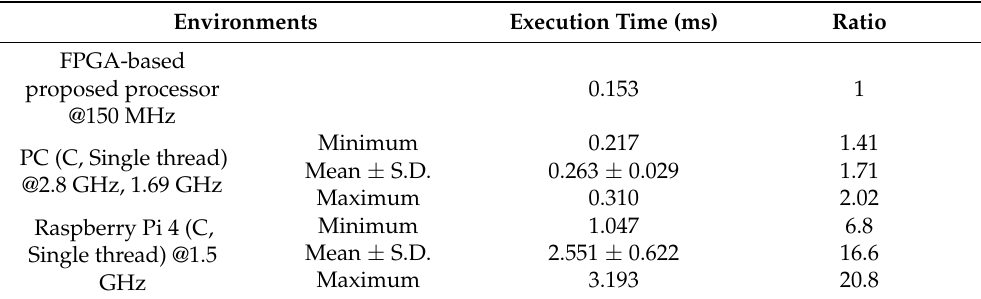
Table 4. Comparison of execution time for a single CIS when R x = 1.0 k Ω , C x = 10 nF, and M was set as 19th order